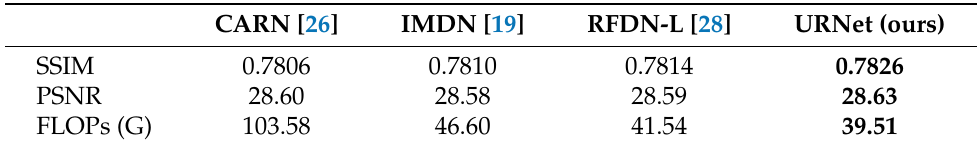
Figure 9. PSNR vs. the number of parameters. The comparison is conducted on Urban100 with the × 3 scale factor. Table 5. PSNR/SSIM vs. FLOPs on Set14 ( ×